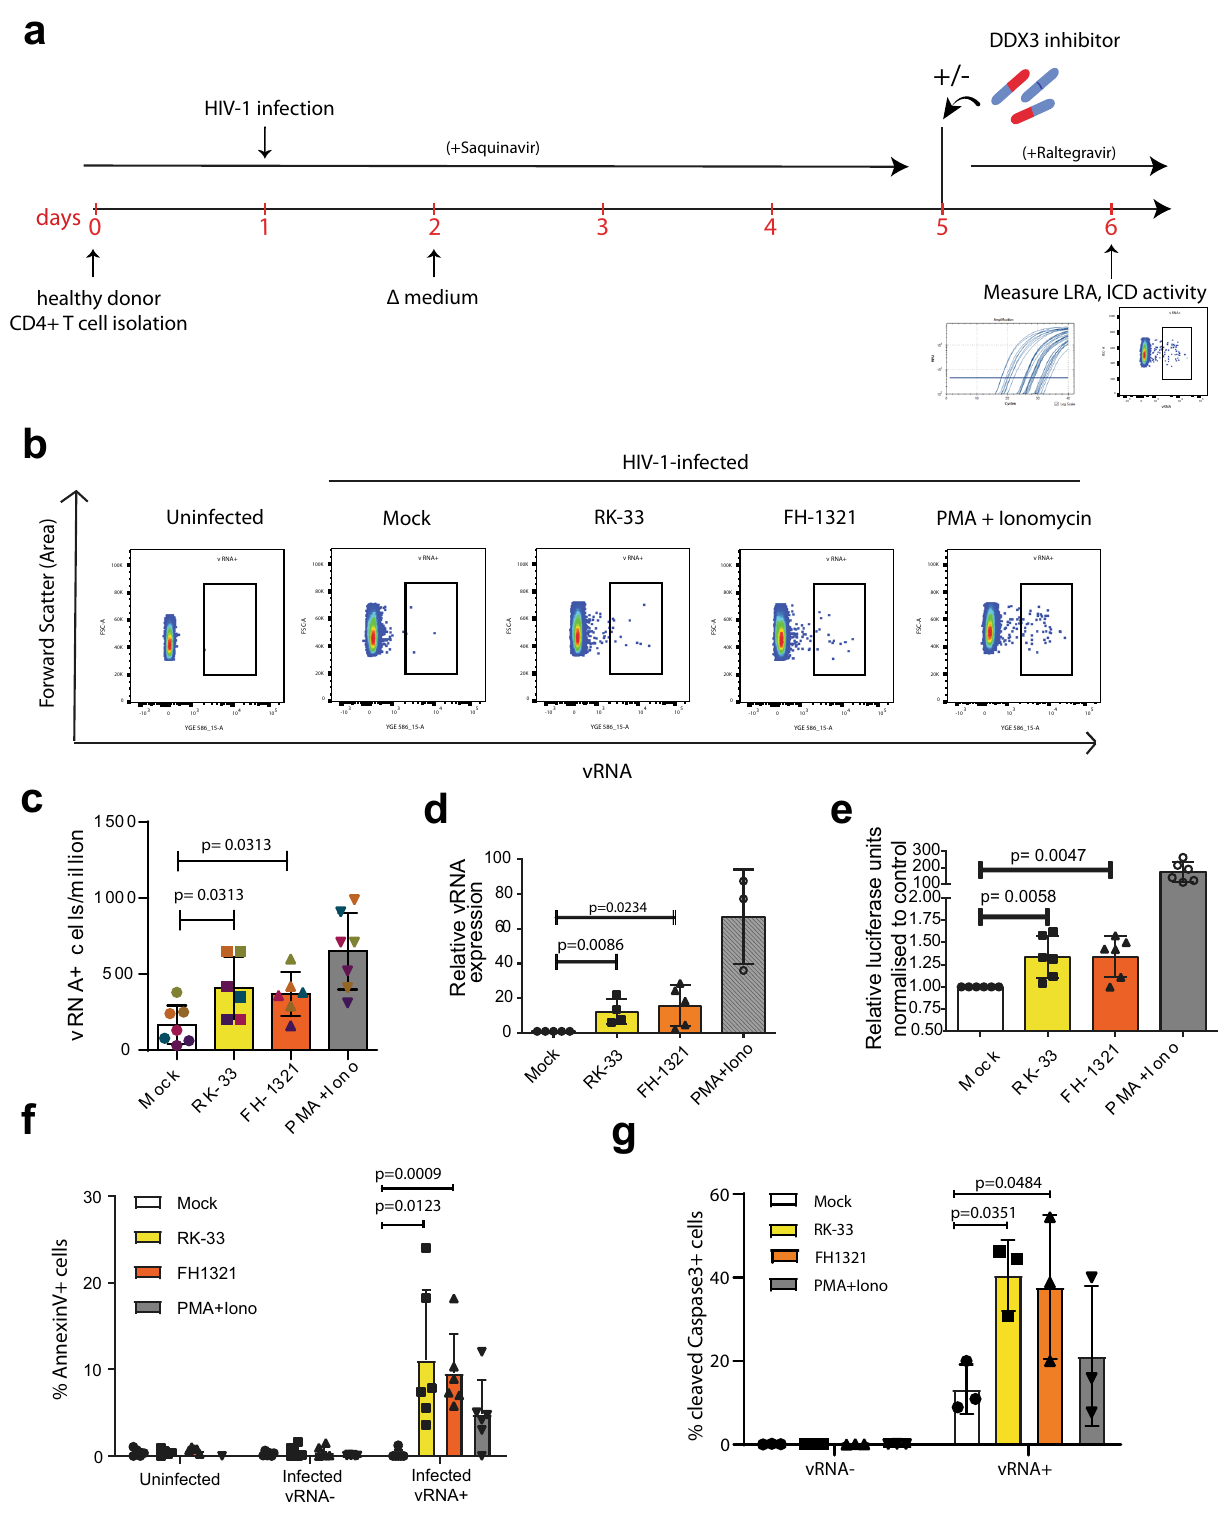
7 positive as compared to the 13.3 (s.d. ± 5.9)% positive cells in the Mock-treated condition (Fig. 4g). To determine if BIRC5 down- regulation plays a role in latency reversal, we treated J-Lat 11.1 cells with the BIRC5 inhibitor YM155 61 , but did not observe signi fi cant latency reversal, suggesting that BIRC5 plays a more prominent role in the death of vRNA-expressing cells rather than their latency reversal (Supplementary Fig. 5d). We were unable to observe